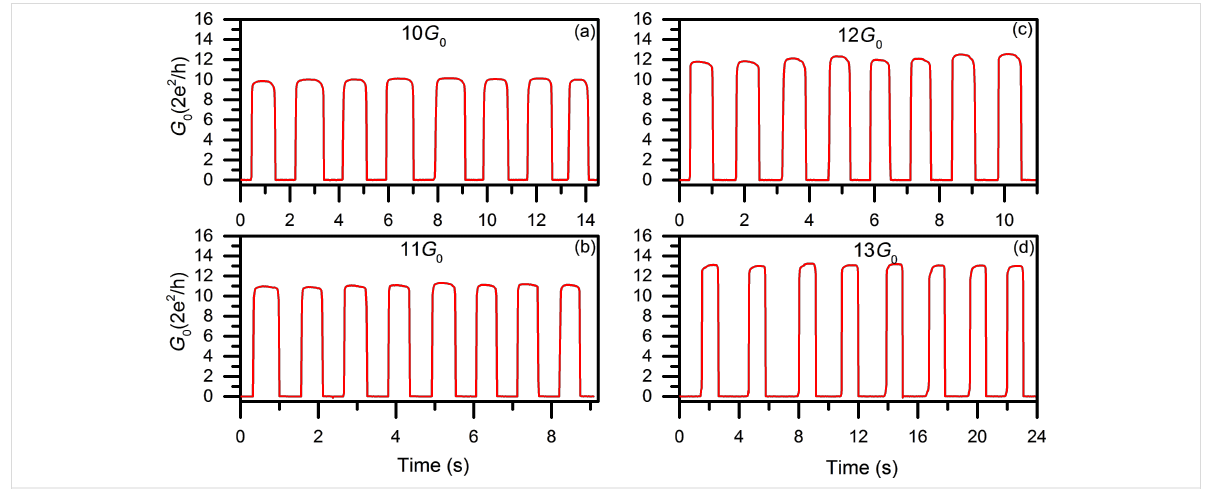
Figure 3: Controlled bistable quantum conductance switching of copper atomic-scale transistors. (a) 0–10 G 0 switching at 0.57 Hz, U G : − 40 mV/210 mV (off/on). (b) 0–11 G 0 switching at 0.73 Hz, U G : − 60 mV/120 mV. (c) 0–12 G 0 switching at 0.89 Hz, U G : − 80 mV/140 mV. (d) 0–13 G 0 switching at 0.33 Hz, U G : − 80 mV/240 mV.